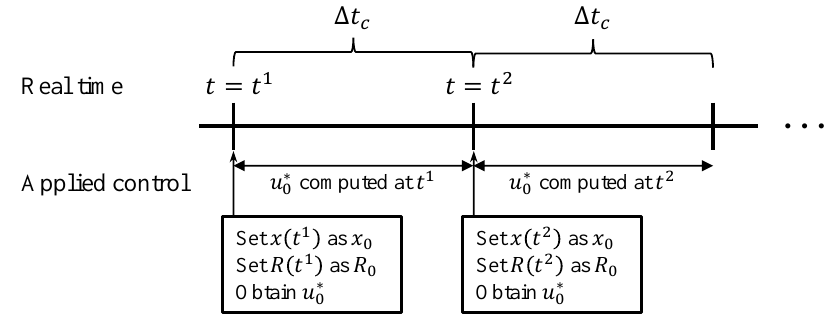
Figure 2. Model Predictive Control (MPC)